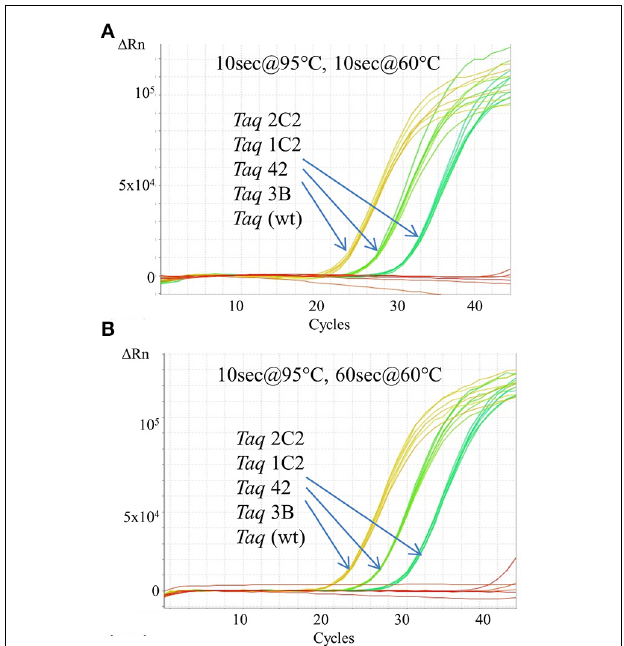
FIGURE 3 | Fast cycling with TaqMan detection. An Assays-on-Demand assay (Life Technologies; 171bp β -actin target) was performed using 50, 5, 0.5ng human genomic DNA and 10ng of purified wild-type or mutant Taq DNA polymerase. Reactions were cycled on the StepOnePlus instrument using cycling conditions consisting of 2min at 95 ◦ C followed by 40 cycles of: (A) 10s at 95 ◦ C, 60s at 60 ◦ C; or (B) 10s at 95 ◦ C, 10s at 60 ◦